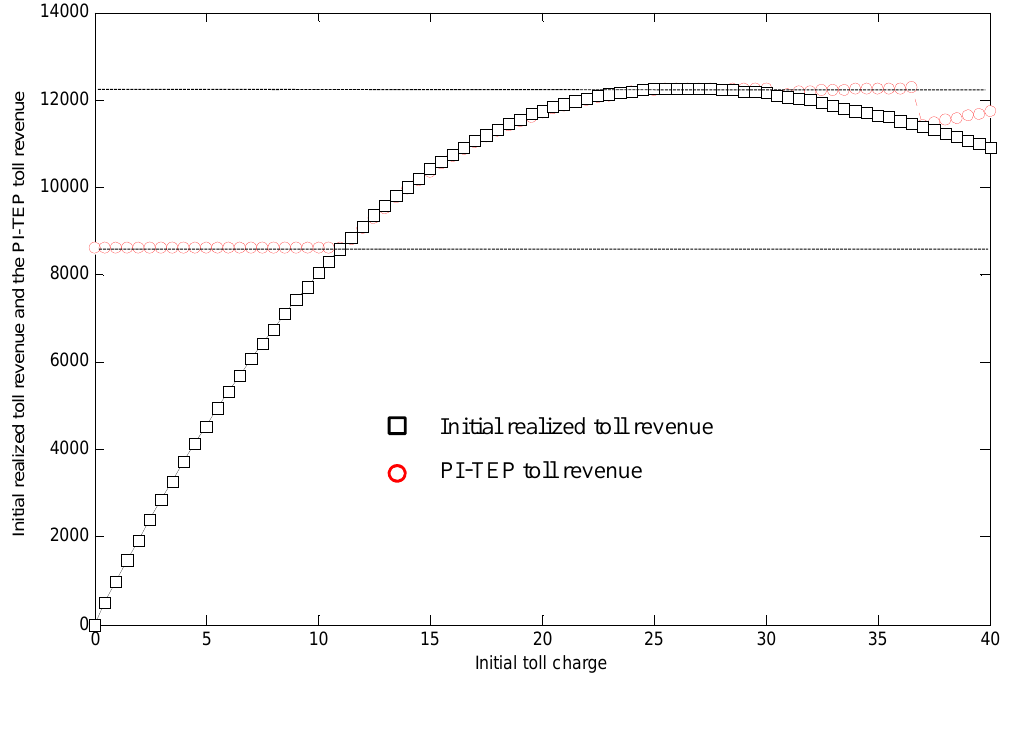
Figure 5. Realized toll revenue before and after